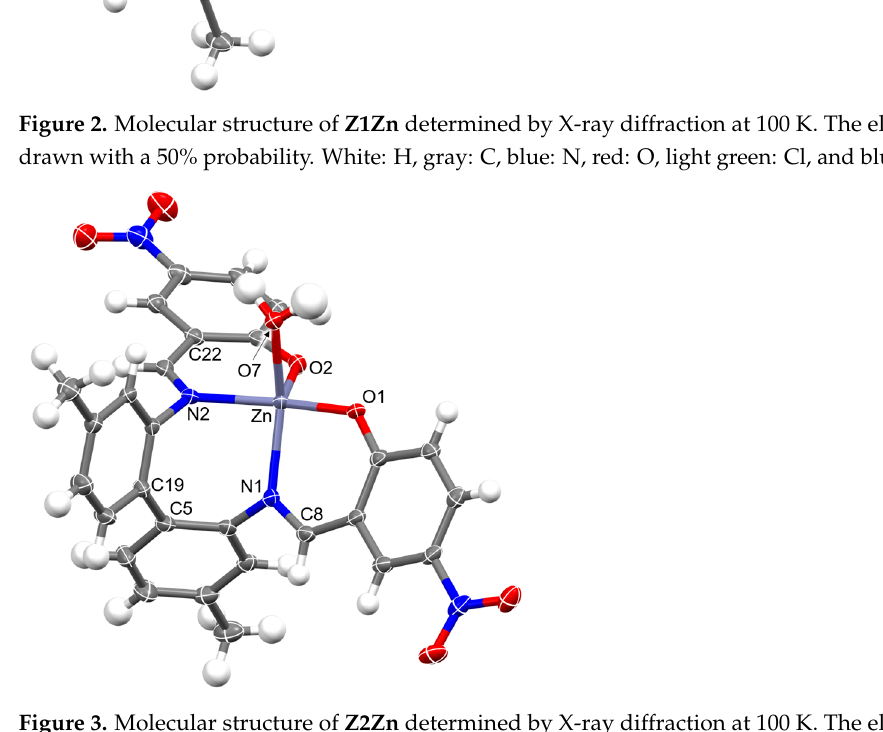
Figure 3. Molecular structure of Z2Zn determined by X-ray diffraction at 100 K. The ellipsoids are drawn with a 50% probability. White: H, gray: C, blue: N, red: O, and blue-gray: Zn.